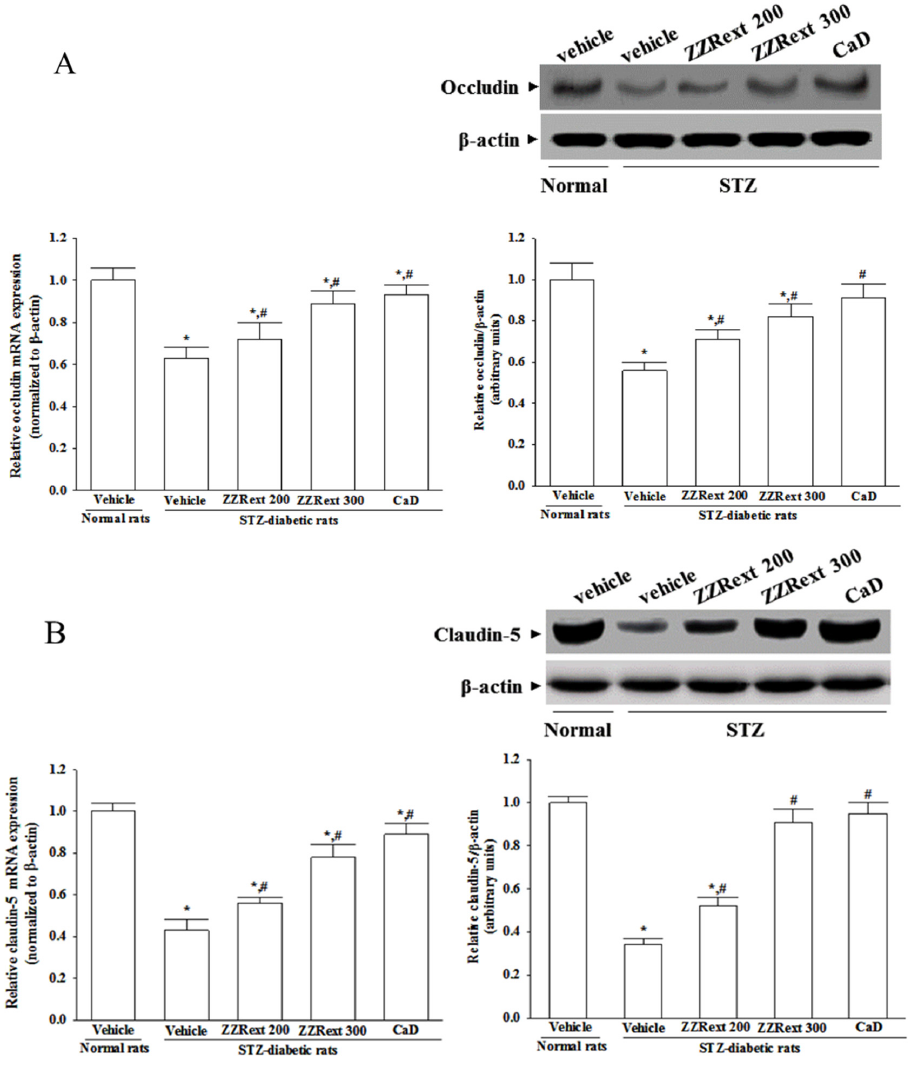
Figure 2. Cont. Figure 2.